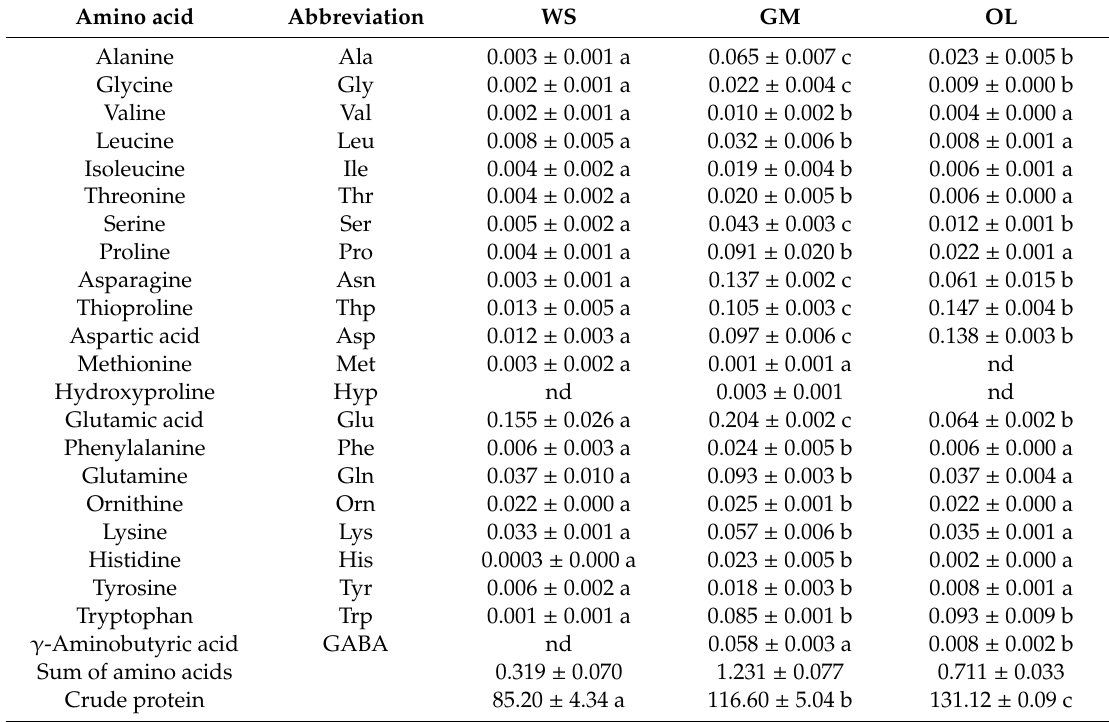
Table 2. Free amino acids and crude protein content in the mushroom cultivation substrates